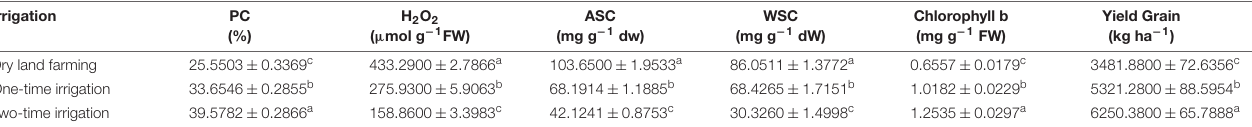
FIGURE 2 | Mean comparisons of the dual interaction effect of biofertilizers × cultivars on root volume trait of wheat plant in two seasons of experiment (2017–2018 and 2018–2019). Means in each column followed by similar letter(s) are not significantly different at 1% probability level by the LSD test. TABLE 3 | Mean comparisons of simple main effects of irrigation levels on some traits in the wheat plant in